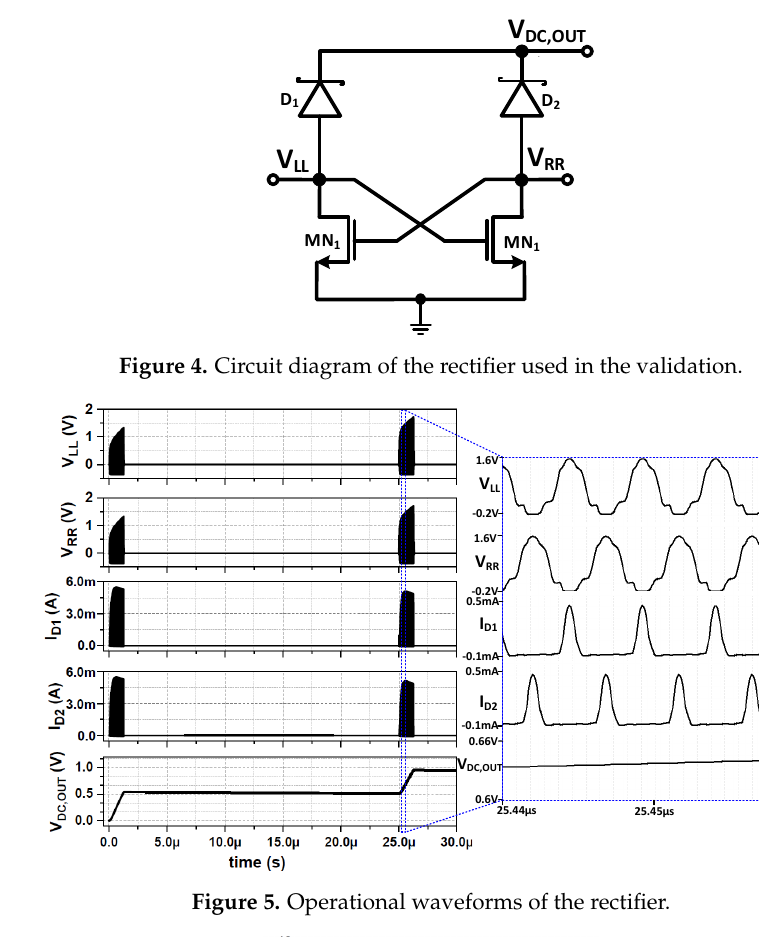
Figure 5. Operational waveforms of the rectifier.